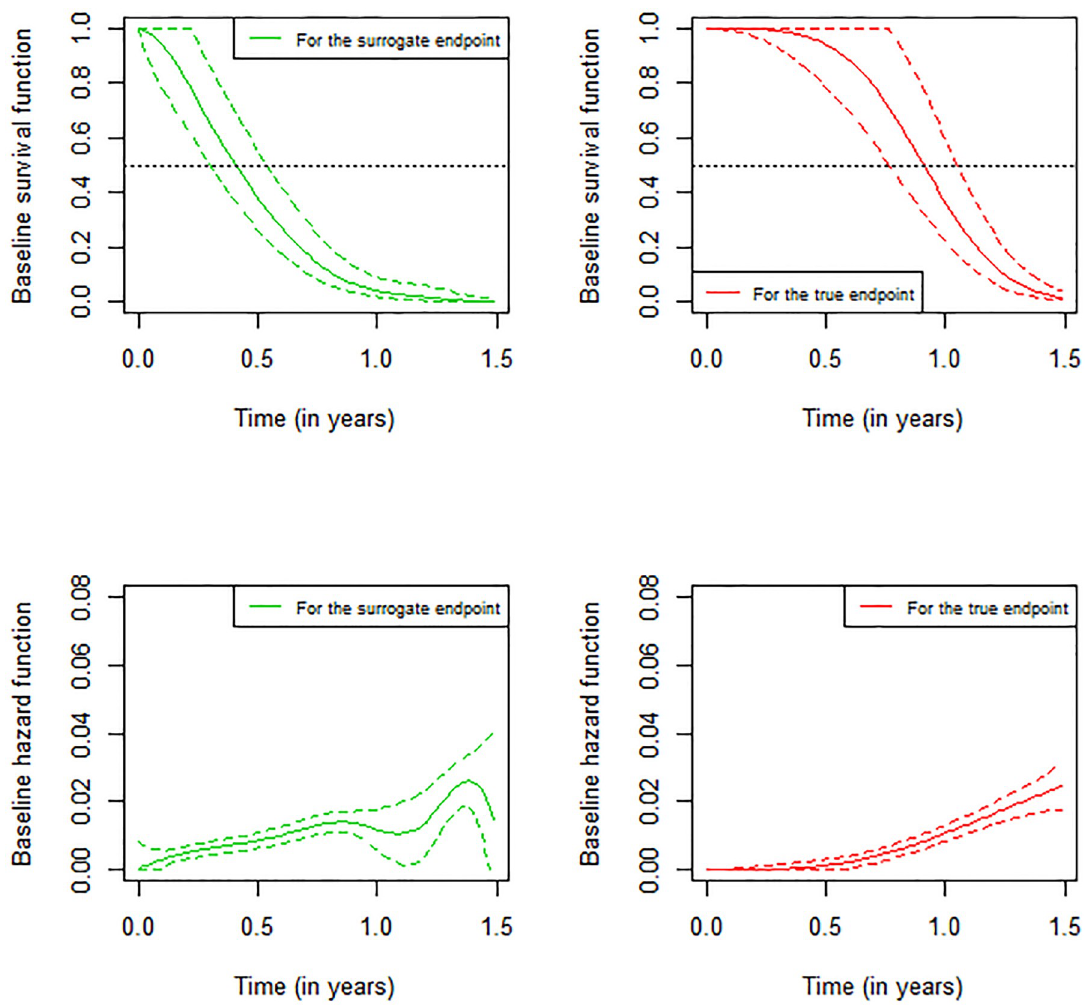
Fig 2. Baseline hazard and survival functions for surrogate endpoint and true endpoint, using simulated meta-analysis of 600 subjects and 30 trials.